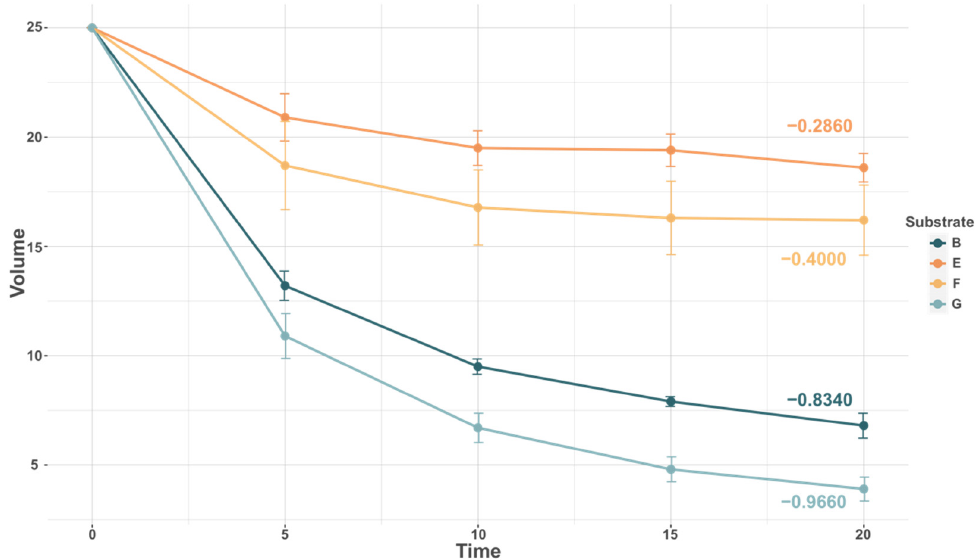
Figure 4. Regression of the floating plastic pellet volume over time due to settlement in the substrate present in the gutter. Four substrate types were tested (B: non-woven geotextile Kena260 black; E: control, shell fragments; F: shell fragments with wood sticks; G: geotextile 3D knitted fabric based on PES knit and PA spacers with wood sticks), with four replicates each. The value of the slope shown in the figure is extracted from a linear regression model.